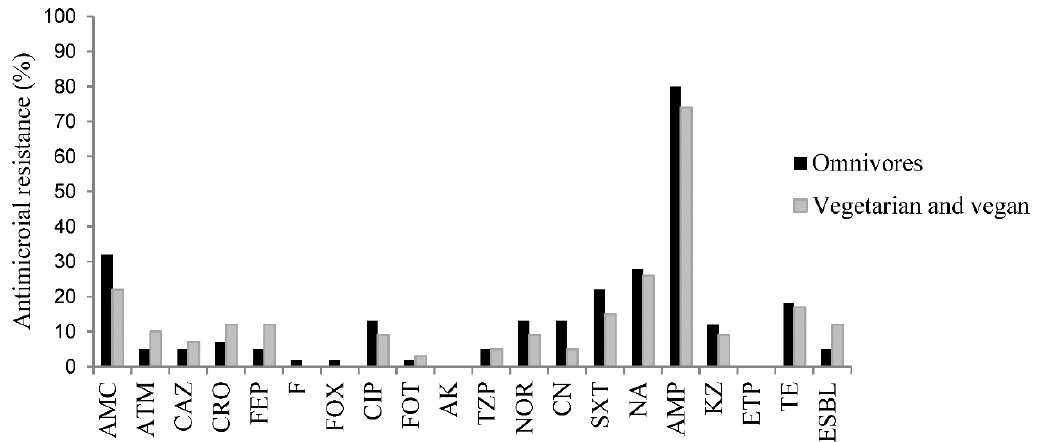
Figure 1. Percentage of antimicrobial resistance profile of E. coli isolated from omnivores and vegetarians/vegans. Amoxicillin-clavulanic acid (AMC), Aztreonam (ATM), Ceftazidime (CAZ), Ceftriaxone (CRO), Cefepime (FEP), Nitrofurantoin (F), Cefoxitin (FOX), Ciprofloxacin (CIP), Cefotaxime (FOT), Amikacin (AK), Piperacilin-tazobactam (TZP), Norfloxacin (NOR), Gentamicin (CN), Trimethoprim-sulfamethoxazole (SXT), Nalidixic acid (NA), Ampicilin (AMP), Cefazolin (KZ), Ertapenem (ETP), Tetracycline (TE) and Extended-spectrum β -Lactamase (ESBL).